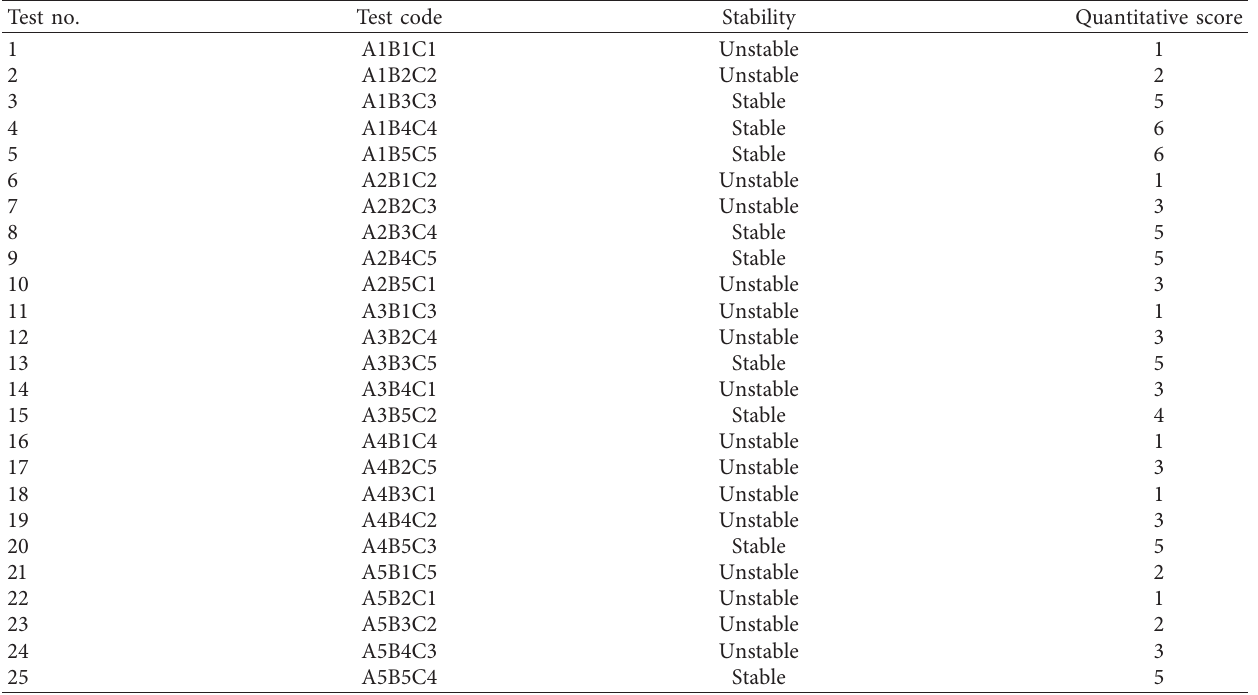
Table 6: Quantification of test data and stability index.